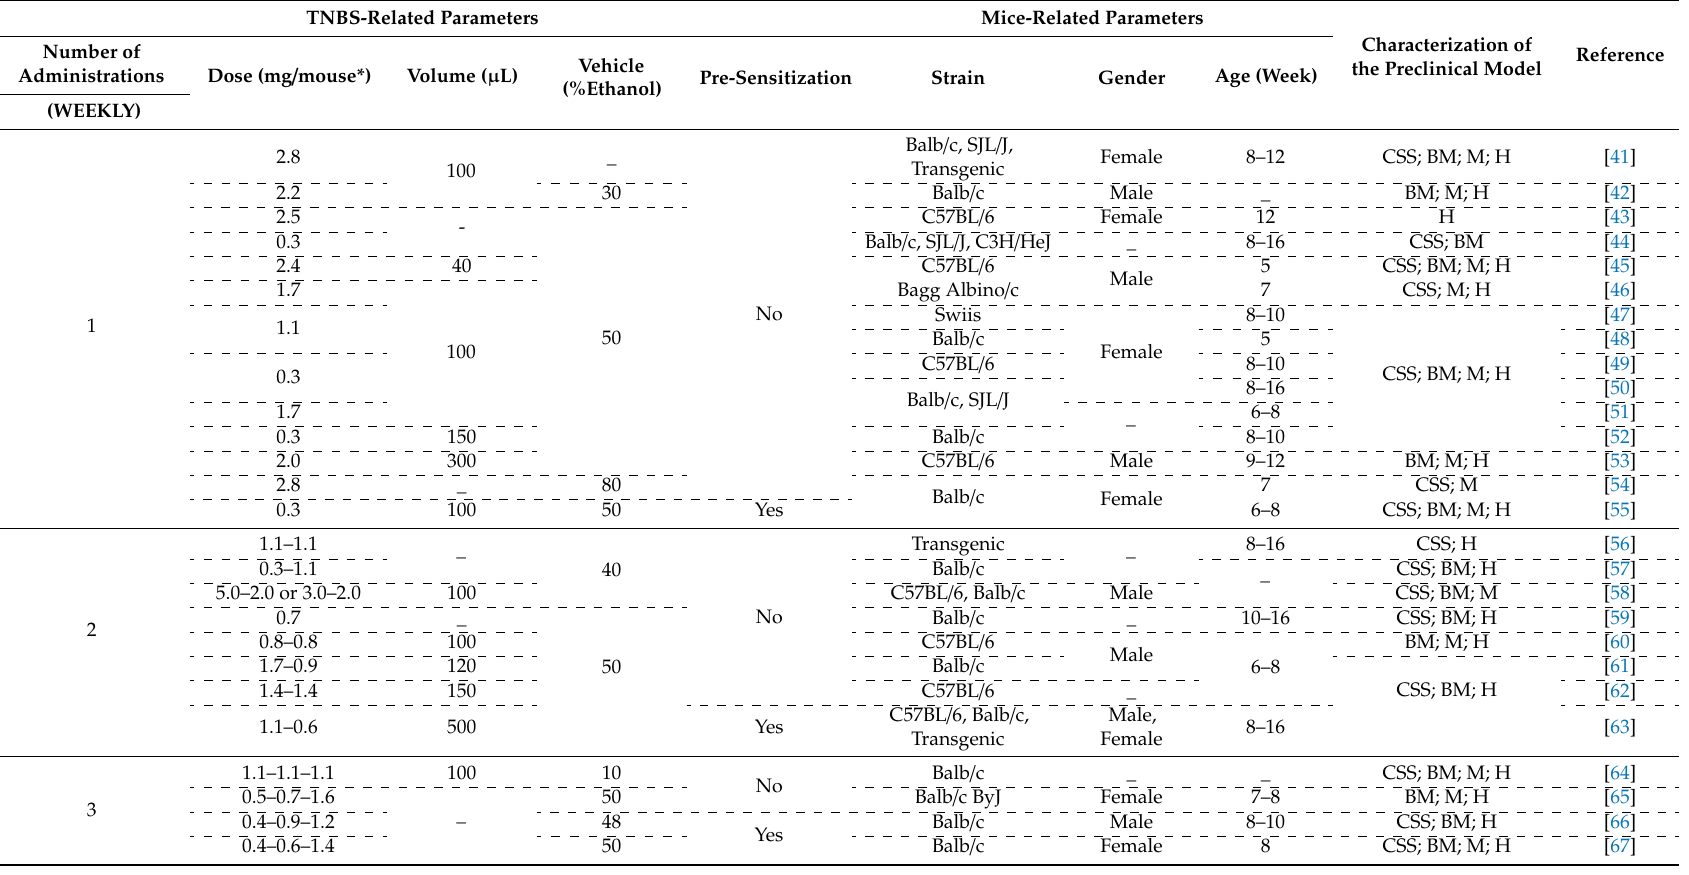
Table 1. Outcomes with chronic models of TNBS-induced